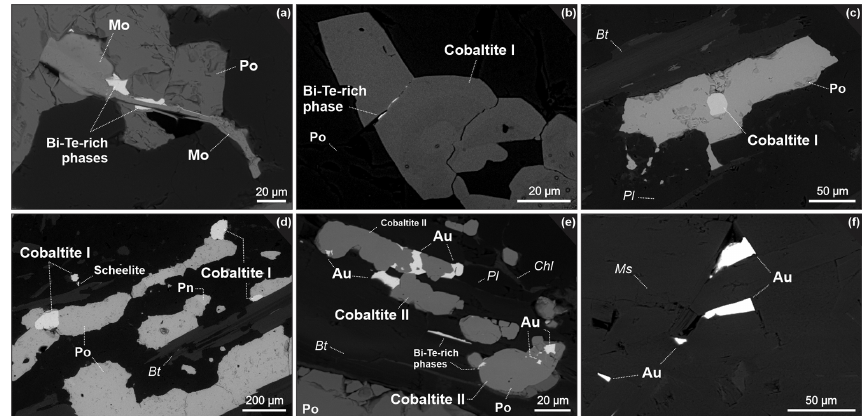
Figure 5. Photomicrographs showing the textural occurrence of pyrrhotite, cobaltite, molybdenite (mo), Bi–Te-rich phases and native gold. (a) Sandwich-textured molybdenite–Bi–Te-rich phase assemblage at pyrrhotite rim; (b) cobaltite I accumulations with Bi–Te-rich phases between grain contacts. This whole assemblage is located along a pyrrhotite rim. (c) Cobaltite I inclusion in pyrrhotite that follows the foliation of the host rock. (d) Cobaltite I at pyrrhotite rim. Assemblage is associated with biotite following rock foliation. Pentlandite (Pn) forming flame-like inclusions in pyrrhotite. (e) Cobaltite II, native Au and Bi–Te-rich phases in mica-rich domains. (f) Void-filling native Au textures in domains of